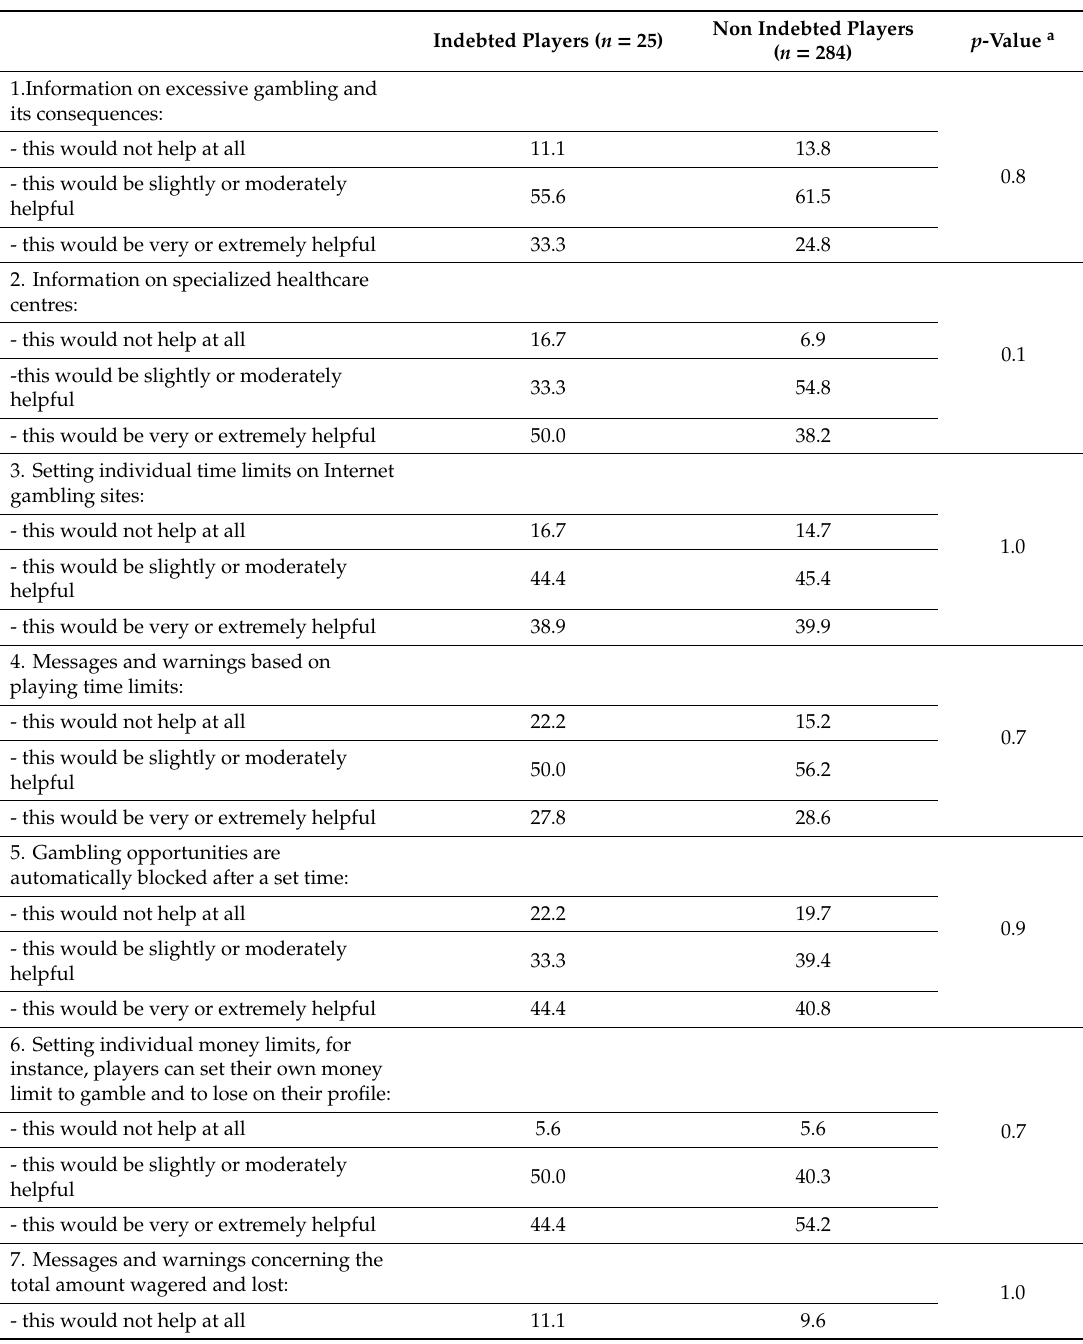
Table 3. Harm reduction items by indebtedness status. Data are expressed as a